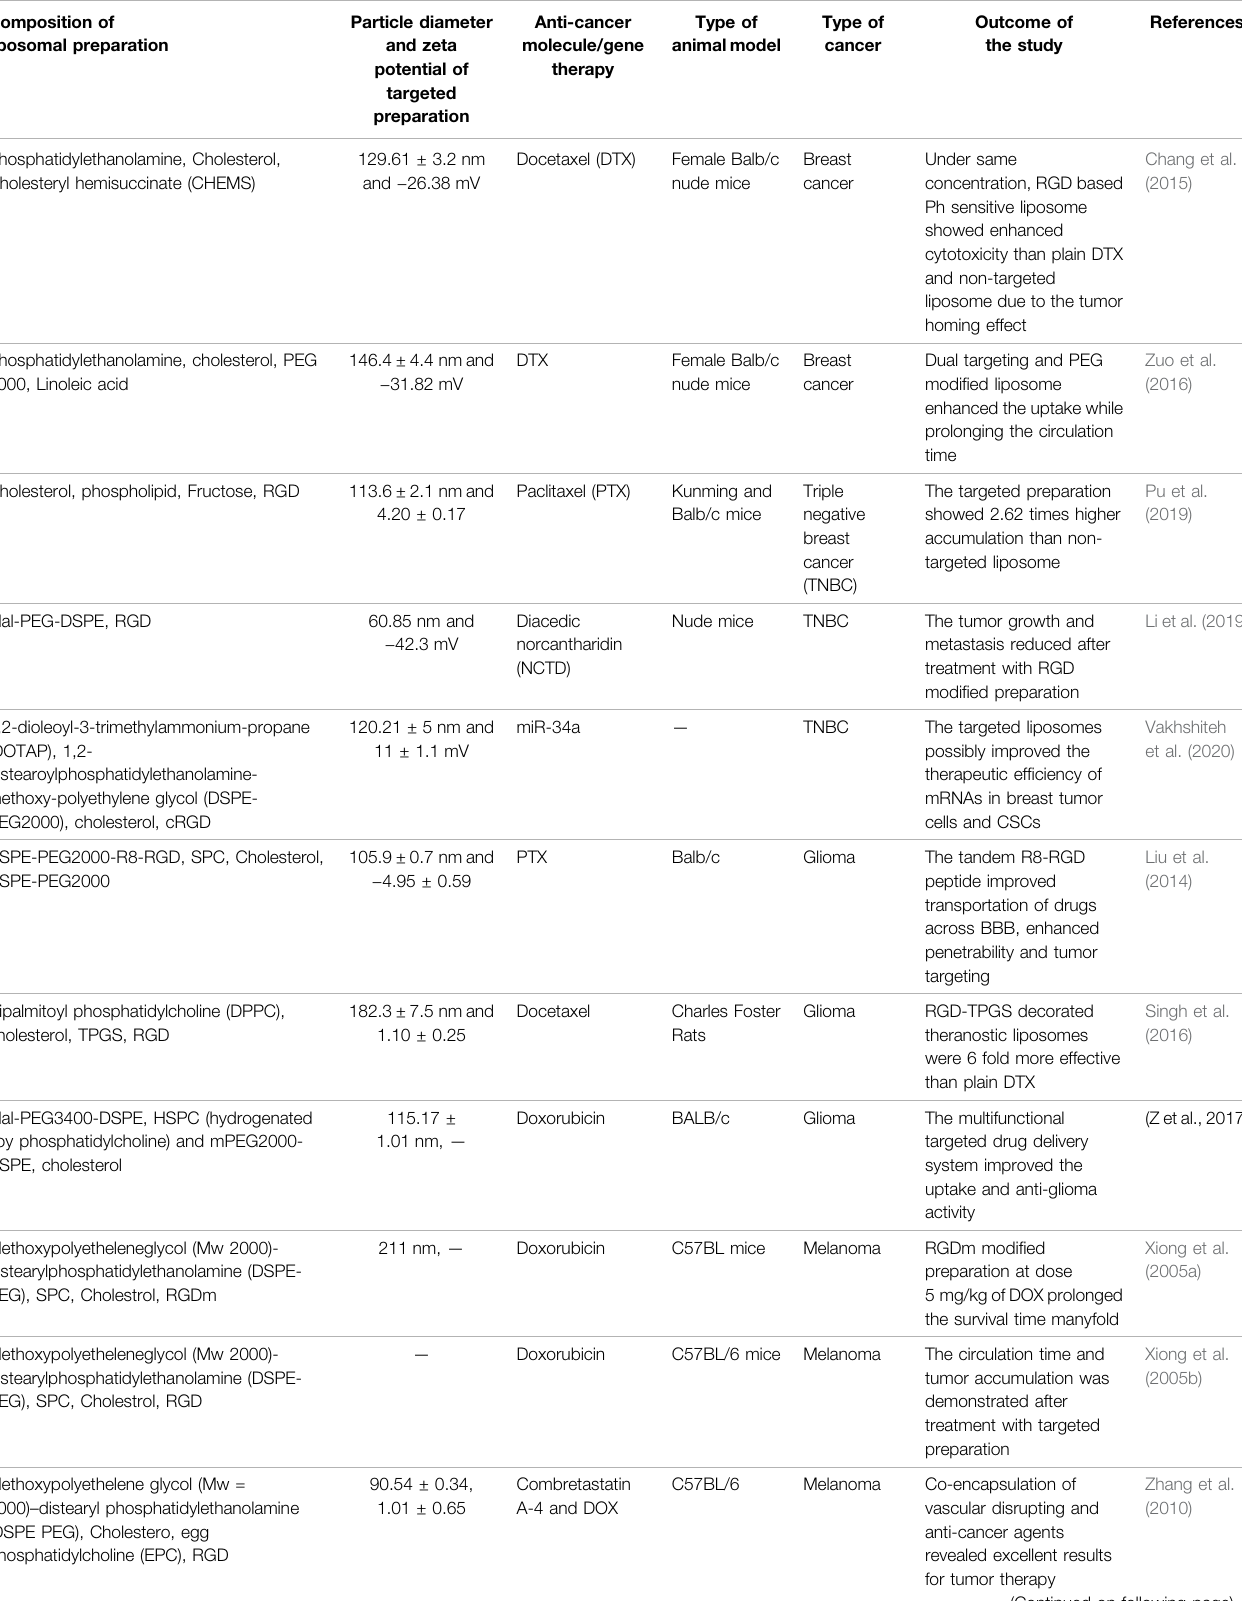
TABLE 1 | Representation of Integrin targeted Liposomal preparation modi fi ed with RGD